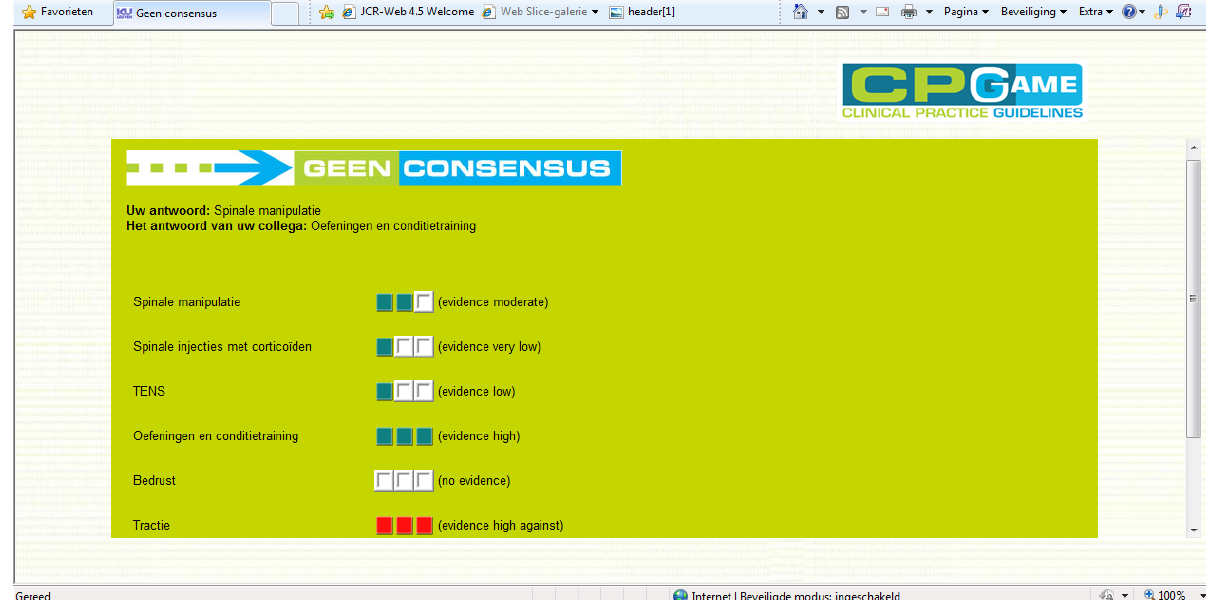
Figure 2. Screen capture of the information displayed on the CPGame when consensus was not reached within a